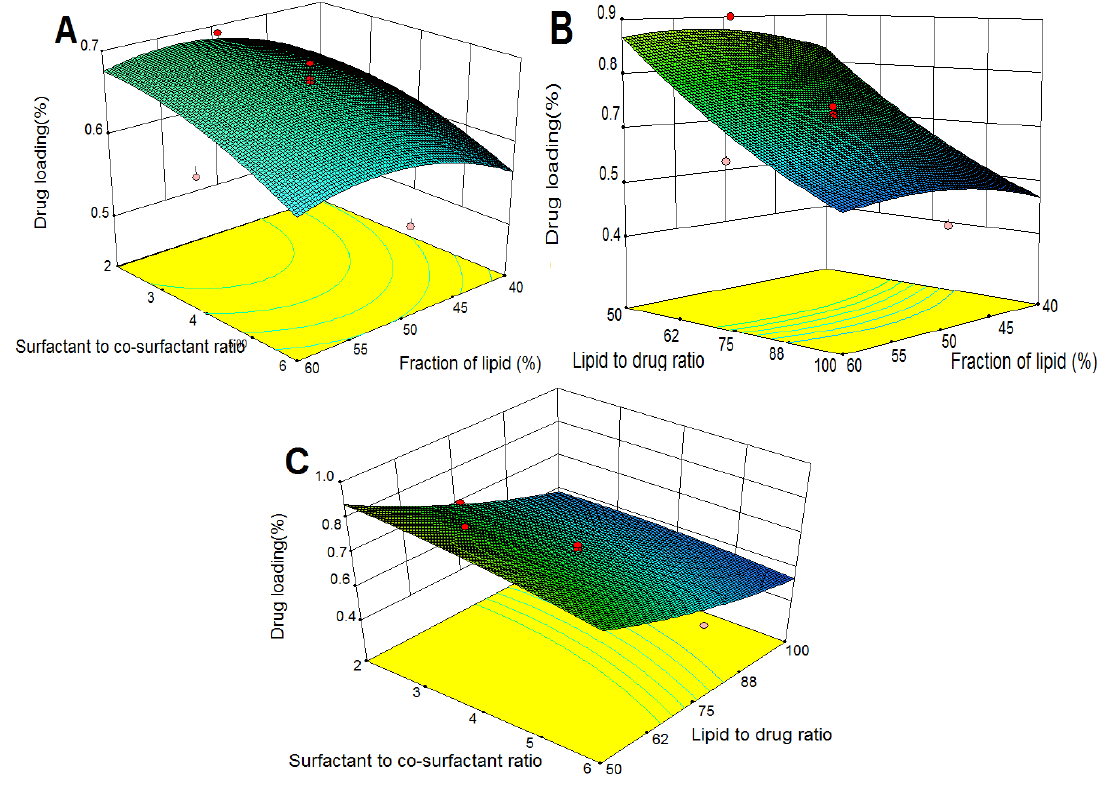
Figure 3. Response surface plots showing the effects of variables on DL of TP-SLN. drug ratio, and ( C ) surfactant to co-surfactant ratio and lipid to drug